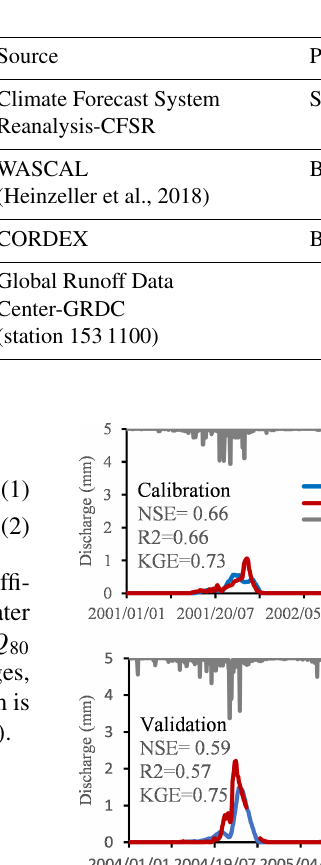
Table 1. Applied datasets.